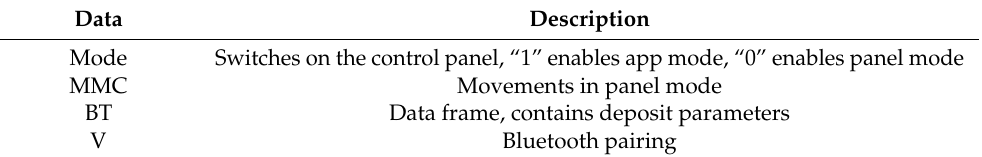
Table 2. Inputs and outputs of the operation of the automated mechanical system.